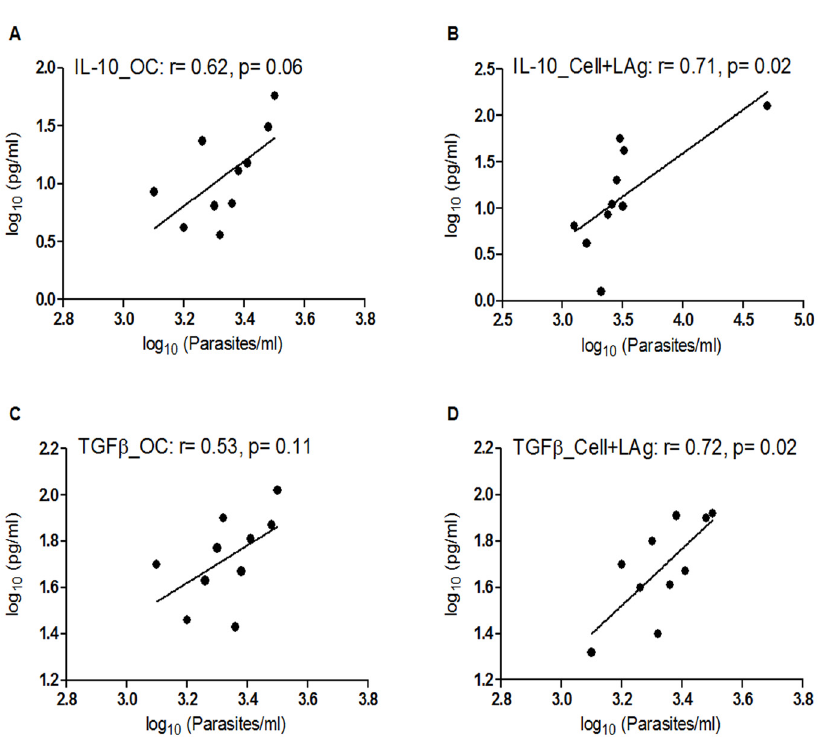
Fig 4. Correlation of different cytokines in culture supernatants of VL patients (n = 10) with parasite load. The unstimulated and LAg-stimulated levels (pg/ml) of IL-10 (panels A and B) and TGF β (panels C and D) in PBMCs of VL patients were measured by ELISA, and parasite loads (Parasites/ml) were determined by real-time PCR. Correlation was calculated using Spearman/Pearson correlation test. Diagonal lines represent linear